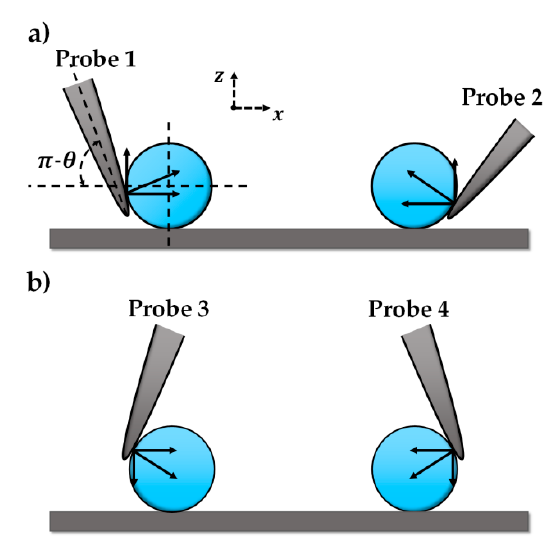
Figure 1. Interactions between the probe tip and microparticles. θ is the angle between the tip centerline and x -axis. ( a ) The tips move microparticles in a push mode, where an upward force is applied on the microparticles. ( b ) The tip moves microparticles in a drag mode, where a downward force is applied on the microparticles.